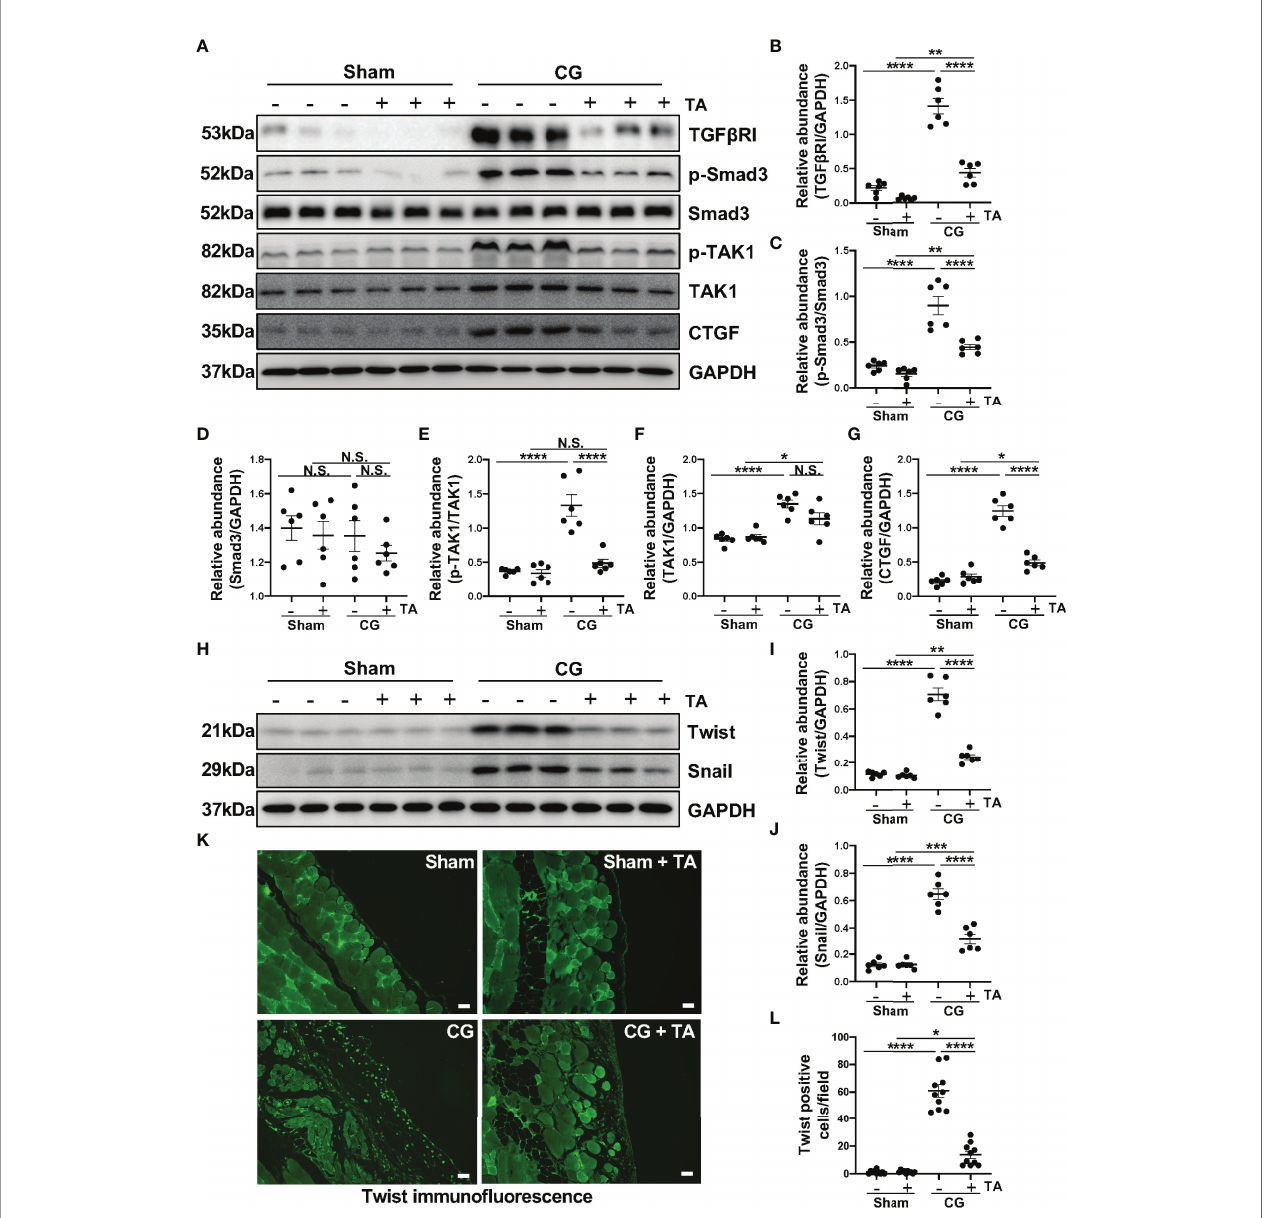
FIGURE 4 | Inhibition of HDAC6 by TA prevents M2 macrophage polarization via suppressing TGF- b 1/Smad3 signaling in vivo . (A) Western blot analysis showed the levels of TGF b RI, p-Smad3, Smad3, p-TAK1, TAK1, CTGF, and GAPDH in peritoneum from different groups of mice. Expression levels of (B) TGF b RI, (C) p- Smad3, (D) Smad3, (E) p-TAK1, (F) TAK1, and (G) CTGF in different groups were quanti fi ed by densitometry and normalized with GAPDH, Smad3, TAK1 respectively. (H) Western blot analysis showed the levels of Twist, Snail, and GAPDH in peritoneum from different groups of mice. Expression levels of (I) Twist and (J) Snail in different groups were quanti fi ed by densitometry and normalized with GAPDH. (K) Representative micrographs of immuno fl uorescence staining of Twist on peritoneum from different groups of mice. (L) Quantization count of Twist-positive cells. Data were expressed as means ± SEM. *P<0.05, **P<0.01, ****P<0.0001. All scale bars = 20 m m. NS: P ≥